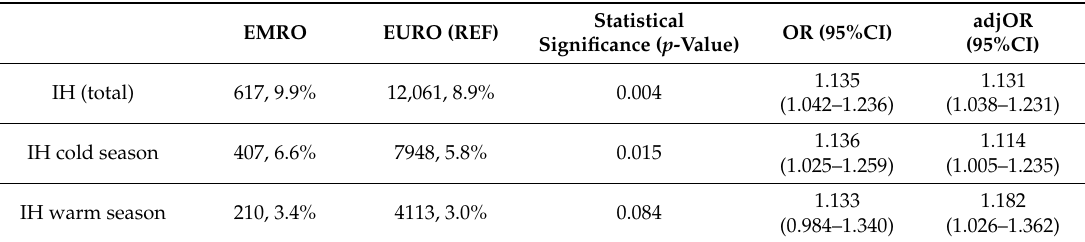
Table 3. Comparison of prevalence rates for OIs in EMRO vs. EURO workers by time-period, i.e., occurring in the Islamic holiday time-period (IH), as a whole and dichotomized in cold season IH (mid September– mid June), and warm season IH (mid June–mid September). EMRO EURO (REF)